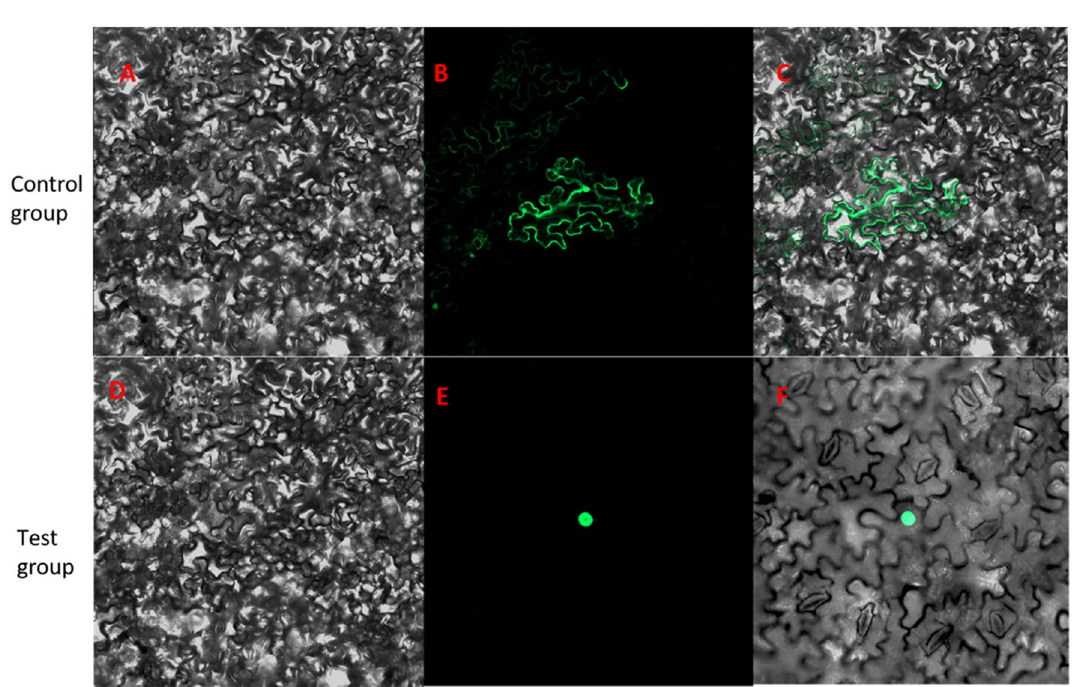
Figure 5. LoHDZ2 subcellular positioning results. ( A ) D dark field observation; ( B ) E tom observation; ( C ) F is the combination of